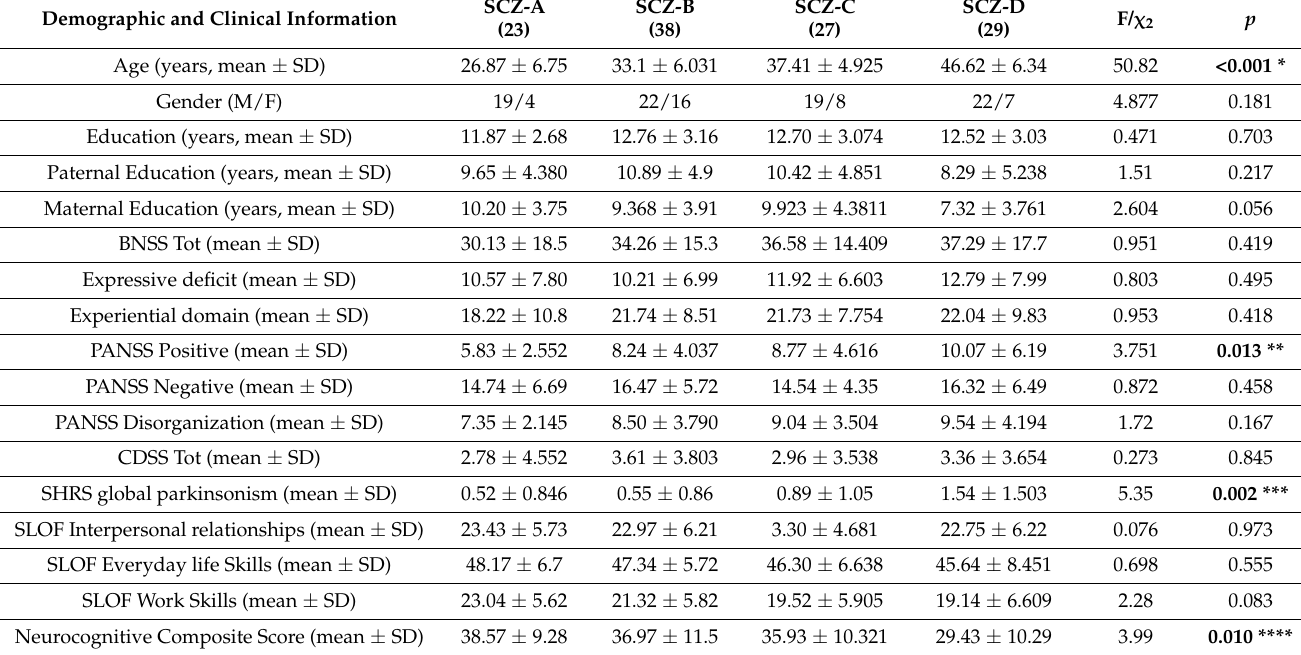
Table 2. Demographic and clinical characteristics of the four patients’ groups, composed by subjects with different illness duration (SCZ-A, ID ≤ 5; SCZ-B, ID 6 to 13 years; SCZ-C, ID 14 to 18 years; SCZ-D, ID 19 to 32 years). Demographic and Clinical Information